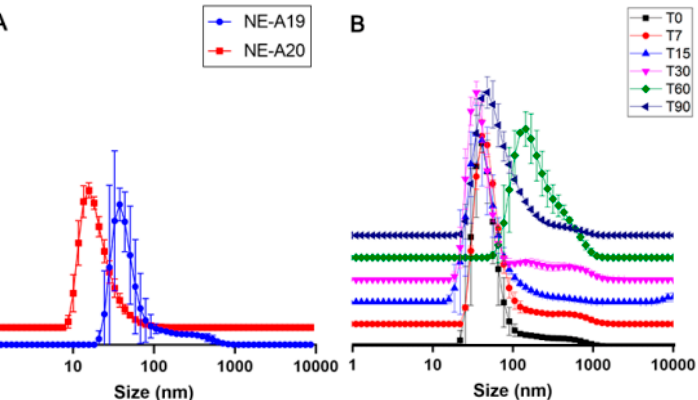
Figure 3. ( A ) Droplet size distribution curves (nm) for NE-A19 and NE-A20. ( B ) Droplet size distribution curves (nm) for NE-A19 during the 90-day stability study.